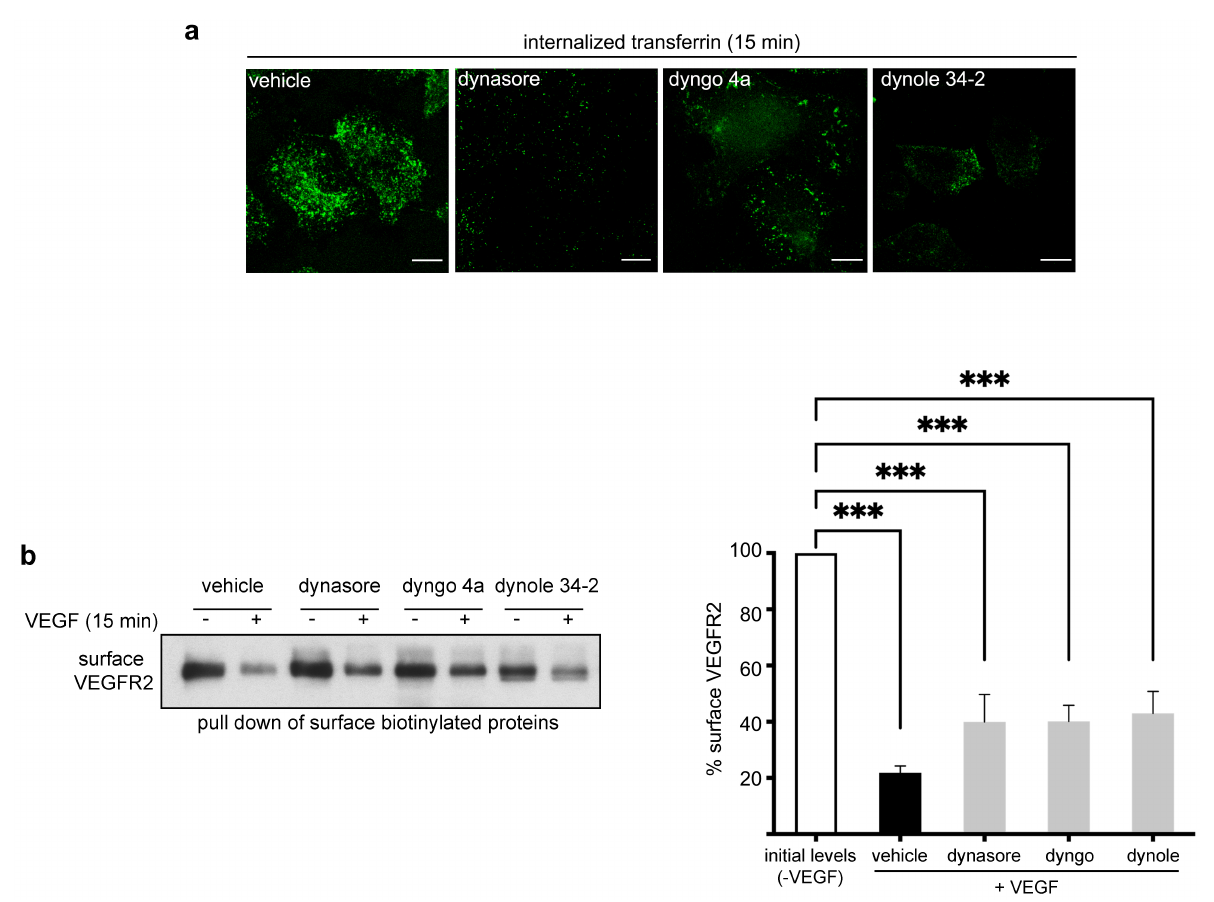
Figure 2. Chemical inhibitors of dynamin consistently block endocytosis of transferrin and inhibit partially the internal- ization of VEGFR2. ( a ) Serum-starved (2 h) HUVECs were treated with vehicle (DMSO) or dynasore (100 µ M) or dyngo 4a (30 µ M) or dynole 34-2 (20 µ M) for 30 min. Subsequently, cells were incubated with FITC transferrin (15 min), fixed and processed for fluorescence microscopy analysis. Prior to fixation, membrane-bound transferrin was removed by acid wash (10 µ m scale bars). ( b ) Analysis of VEGF-induced internalization of surface VEGFR2 through biotinylation of plasma membrane proteins. Serum-deprived HUVECs were treated for 30 min with vehicle or inhibitors of dynamin, i.e., dynasore, dyngo 4a or dynole 34-2, and incubated with VEGF for 15 min. Cells were transferred to 4 ◦ C and surface proteins were labeled with cell-impermeable biotin. Surface biotinylated proteins were pulled down by streptavidin beads and processed for Western blotting analysis. Surface VEGFR2 was revealed by anti-VEGFR2 antibodies. Quantification of surface VEGFR2 is shown on the right of the Western blot (n = 3 independent experiments, mean ± S.E.M., *** p < 0.001, t